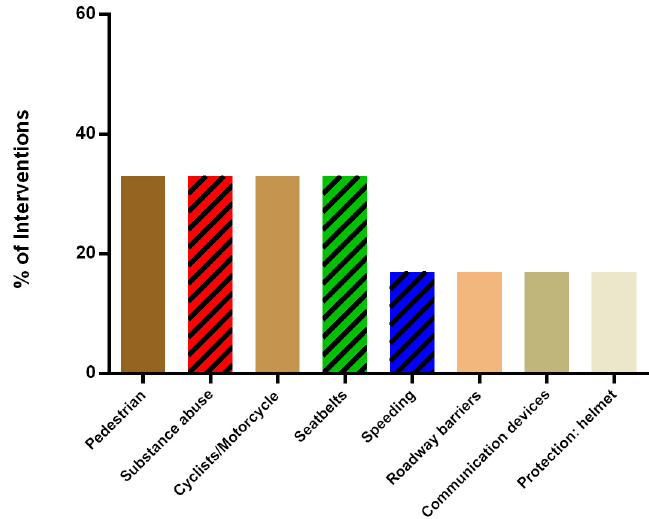
Figure 2. Key issues of “outside” interventions ( n = 12).